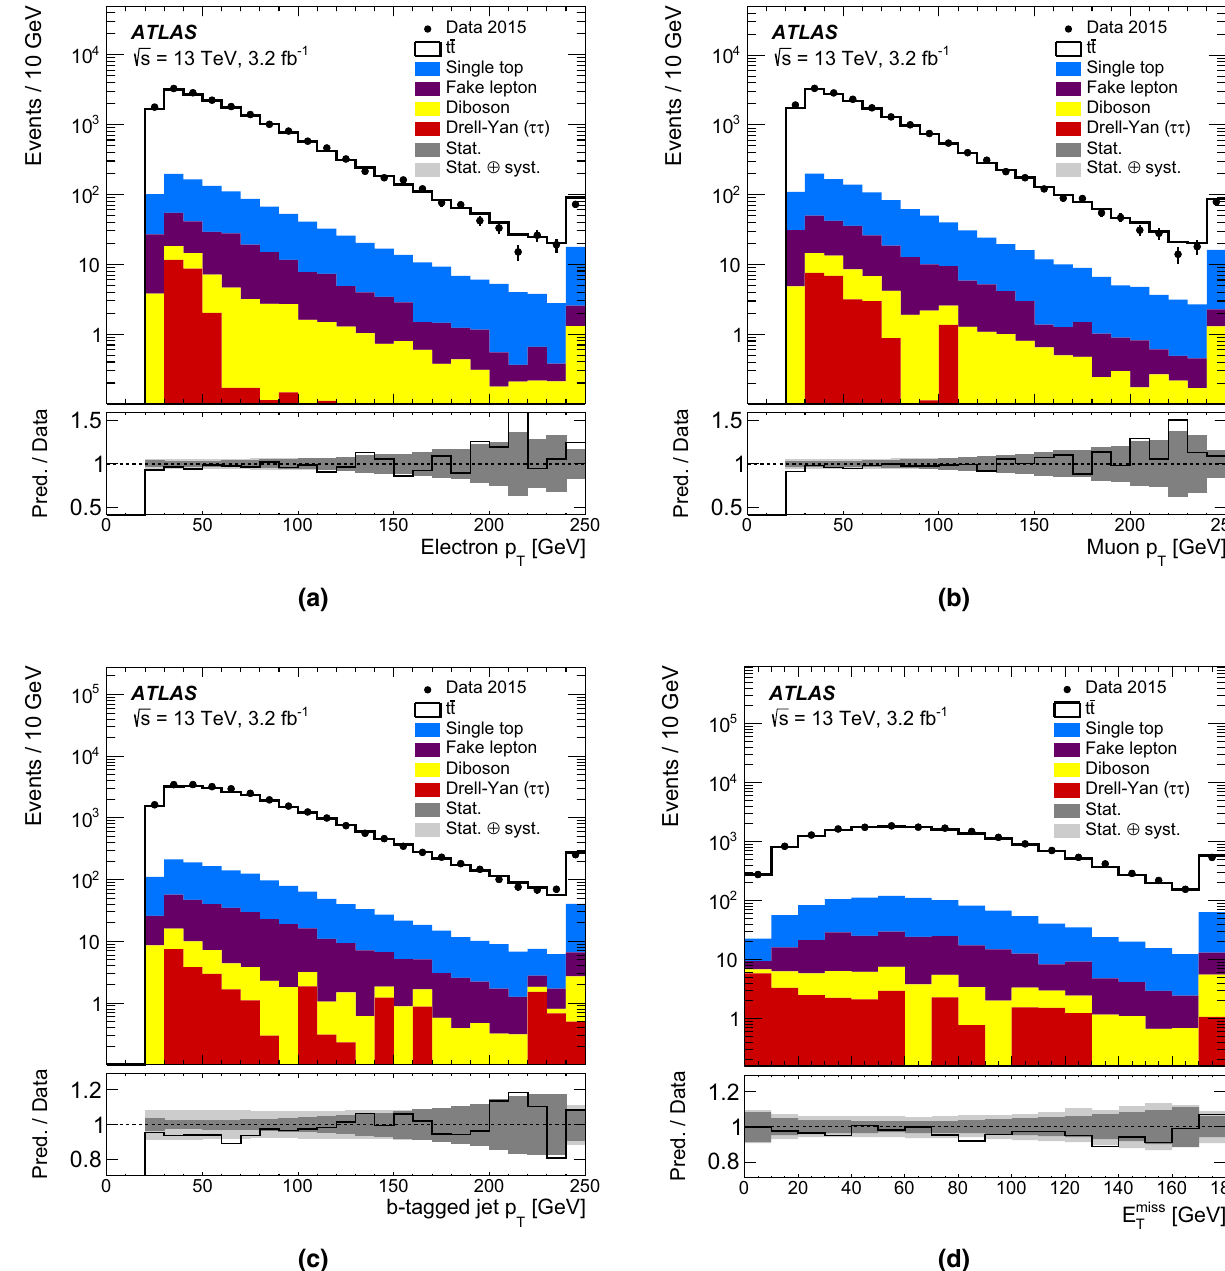
Fig. 1 Kinematic distributions for the electron p T ( a ), muon p T ( b ), cal, systematic and luminosity uncertainties added in quadrature. The b -jet p T ( c ), and E miss uncertainties quoted include uncertainties from leptons, jets, missing ( d ) for the e ± μ ∓ signal selection. In all figures, T transverse momentum, background modelling and pile-up modelling. the rightmost bin also contains events that are above the x -axis range. They do not include uncertainties from PDF or signal t ¯ t modelling The dark uncertainty bands in the ratio plots represent the statistical uncertainties while the light uncertainty bands represent the statisti-